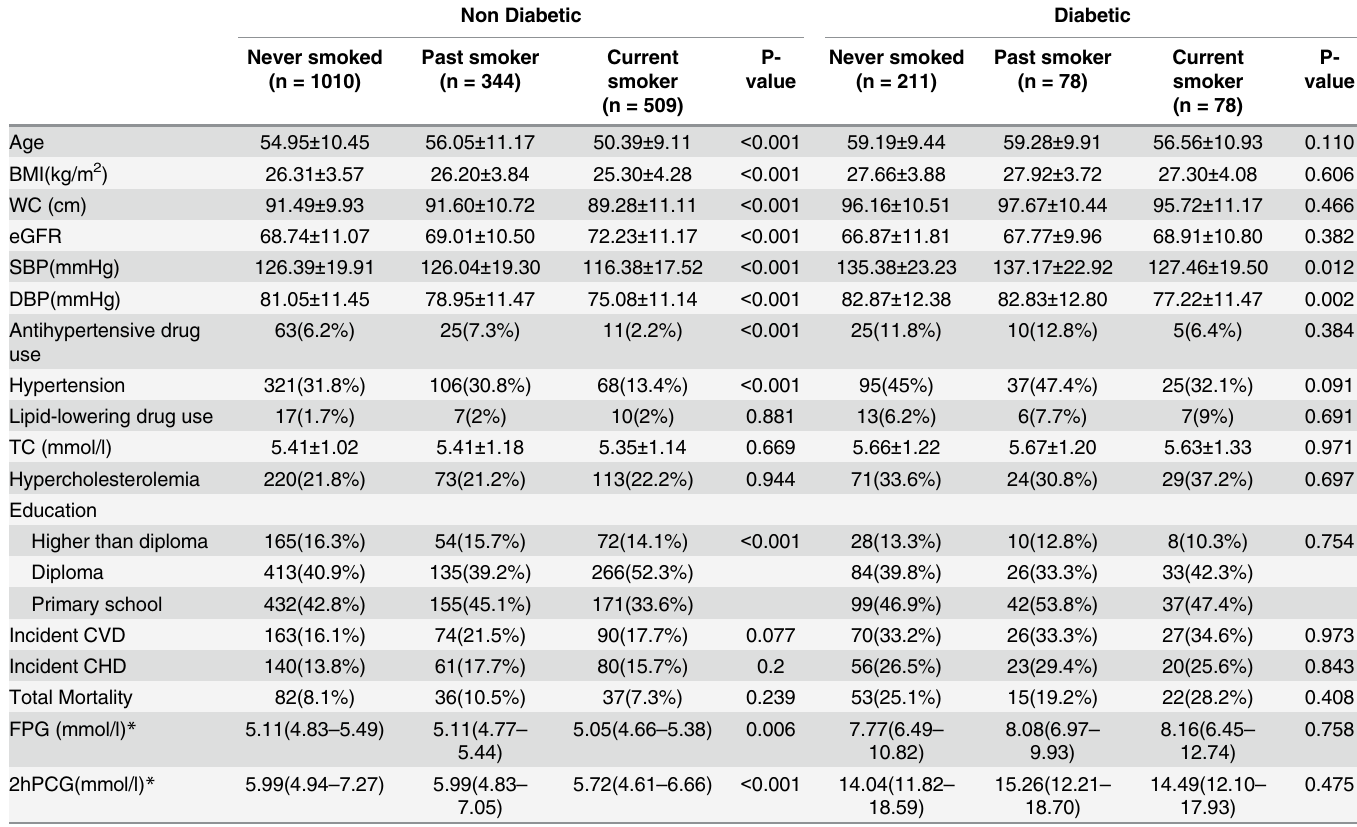
Table 1. Characteristics of participants based on cigarette smoking groups and diabetes status. Tehran Lipid and Glucose study (1999 –